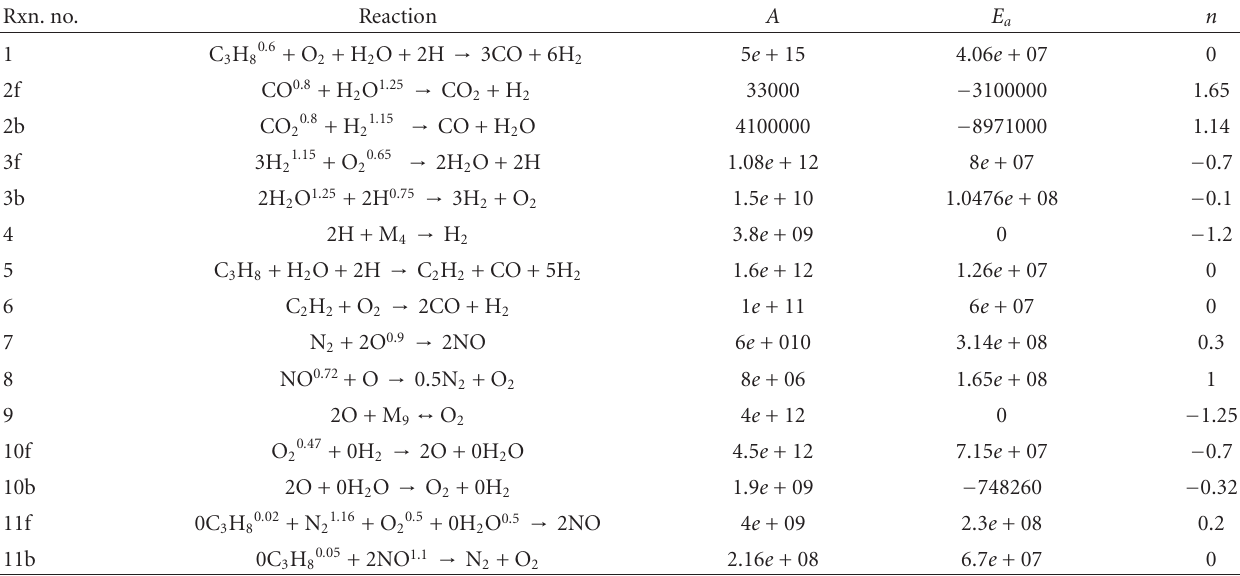
Table 2: C 3 H 8 /NO x global